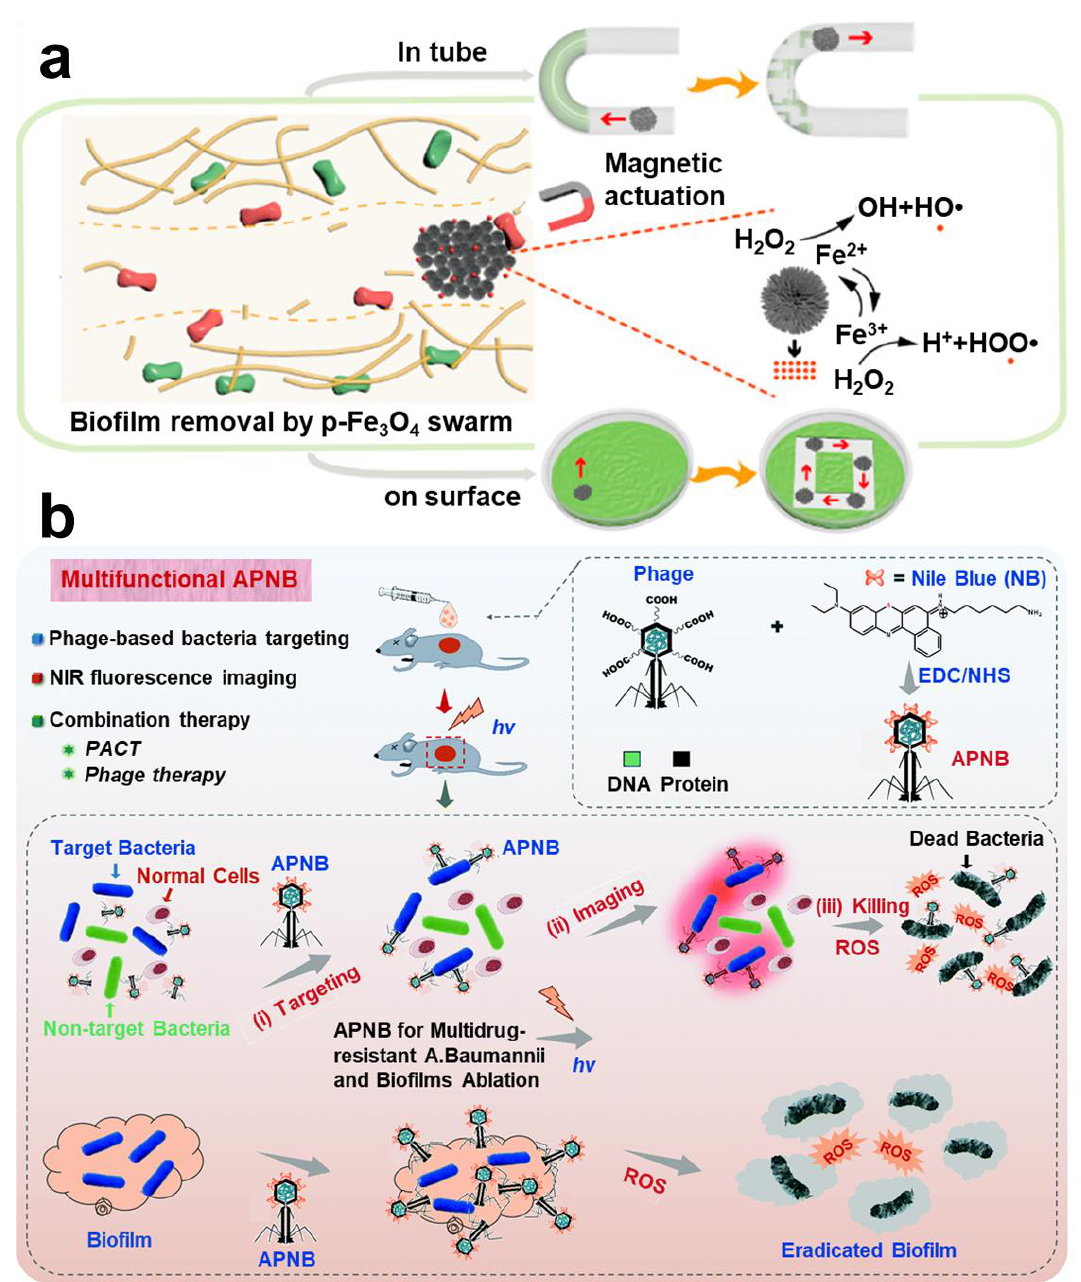
Figure 12. Other targeting strategies in anti-biofilm infection. ( a ) Magnetic targeting nanoparticles prepared by Fe 3 O 4 and the Fenton reaction antibacterial mechanism. Reprinted with permission from Ref. [215]. Copyright 2021, Li Zhang. ( b ) Therapeutic scheme for eradicating biofilm using phage-targeting technology and photodynamic therapy. Reprinted from Ref. [224].